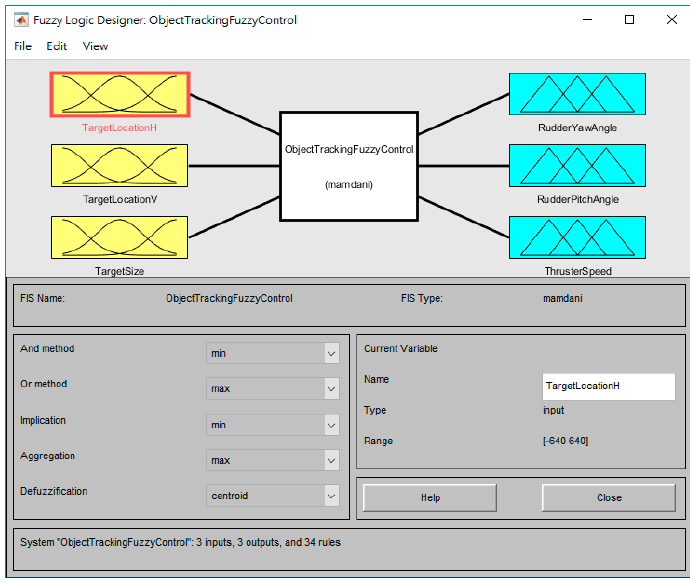
Figure 7. Fuzzy control system structure.